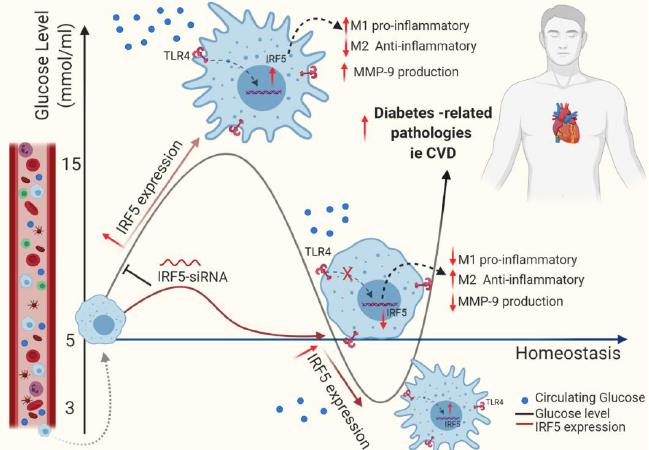
Figure 6. This illustration represents a proposed model of metabolic inflammation in support of the data presented, wherein RIH or glucose fluctuations in vitro upregulate the expression of TLR4-IRF5 together with markers of inflammation and the cardiovascular disease marker MMP-9 in macrophages. These data support the notion that controlling glucose fluctuations and / or IRF5 silencing could be beneficial to alleviate metabolic